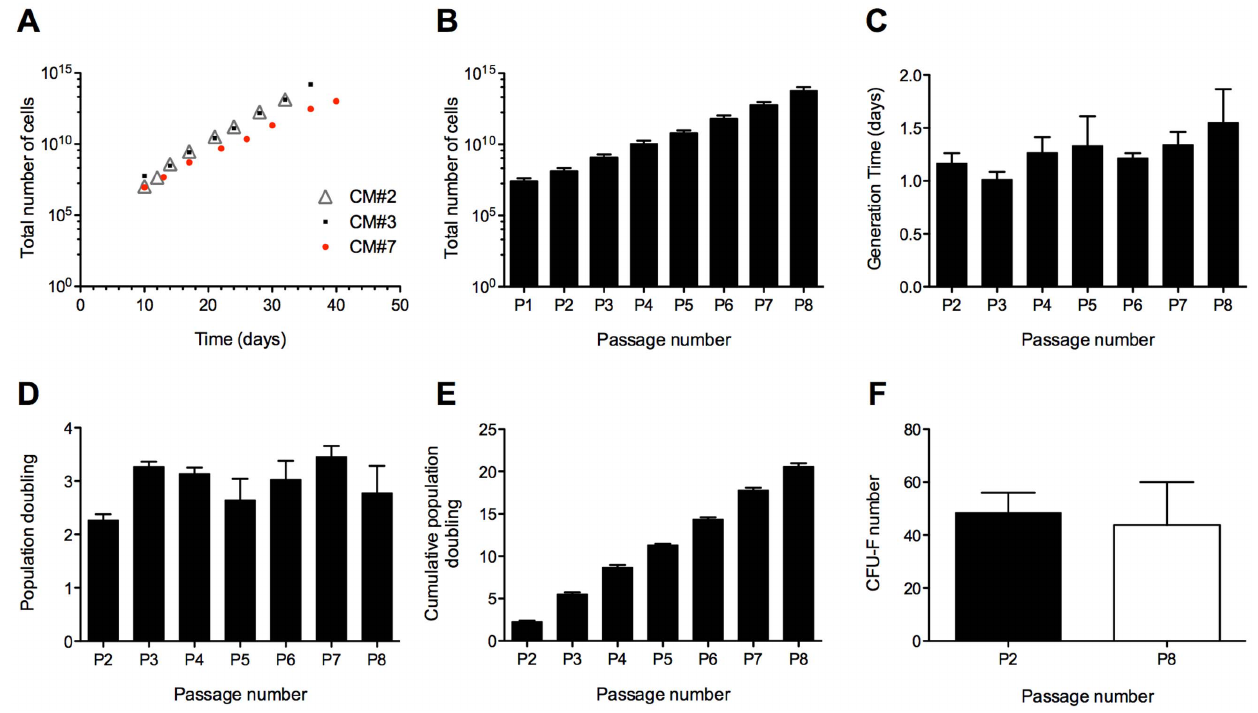
Figure 1. Proliferation and colony-forming capacity of human umbilical cord mesenchymal stem cells (hUCM-MSCs) invitro . Total number of cells (hUCM-MSCs) along time (days) and passage number ( A, B ), generation time ( C ), population doubling ( D ), cumulative population doubling ( E ) from passage 1 (P1) or P2 until P8, as indicated, and colony forming unit-fibroblast (CFU-F) number at P2 and P8 ( F ). Cells were isolated from 3 distinct human umbilical cord matrix samples (CM # 2, # 3 and # 7). From P2 onwards (inclusively), cells were plated at a fixed density of 3,000 cells/cm 2 , allowed to proliferate until sub-confluence and re-plated in the same way ( A-E ), or plated at 3 cells/cm 2 at P2 and P8 and cultured for 15 days for the CFU-F study ( F ). The total number of cells (TNC) was determined at each passage (P1-P8) by cumulative counting of the cells once they reached a confluence of 80% ( A, B ). The TNC designates the theoretical number of cells that could be obtained if no cells were discarded between each passage. The observed mean generation time (GT) was between 1.02 ( 6 0.071) and 1.55 ( 6 0.316) days ( C ), and no statistically significant differences were found in GT from passages 2 to 8 (Kruskal-Wallis one-way ANOVA followed by Dunn’s Multiple Comparison test). The CFU-F capacity was maintained from P2 to P8 ( F ) and no statistically significant differences were found (two-tailed Mann-Whitney test). Bars represent mean 6 SEM ( B-F ).